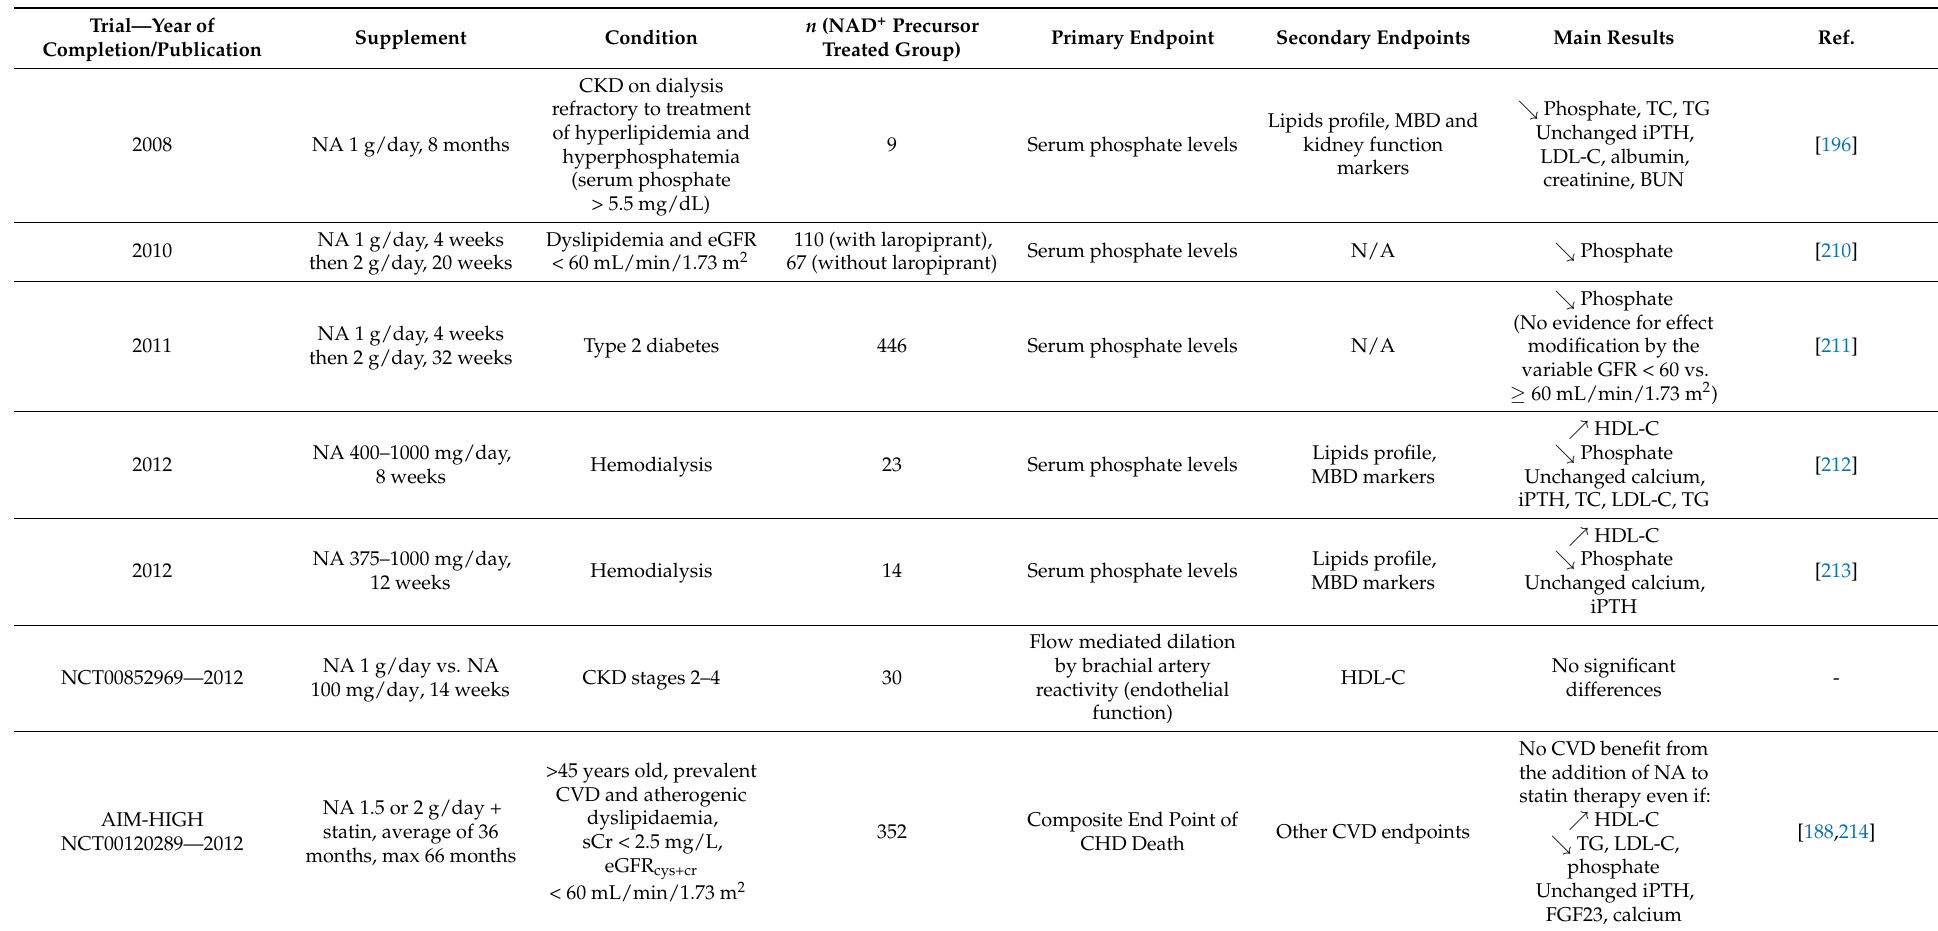
Table 2. Clinical trials using NAD + precursors in premature renal aging and